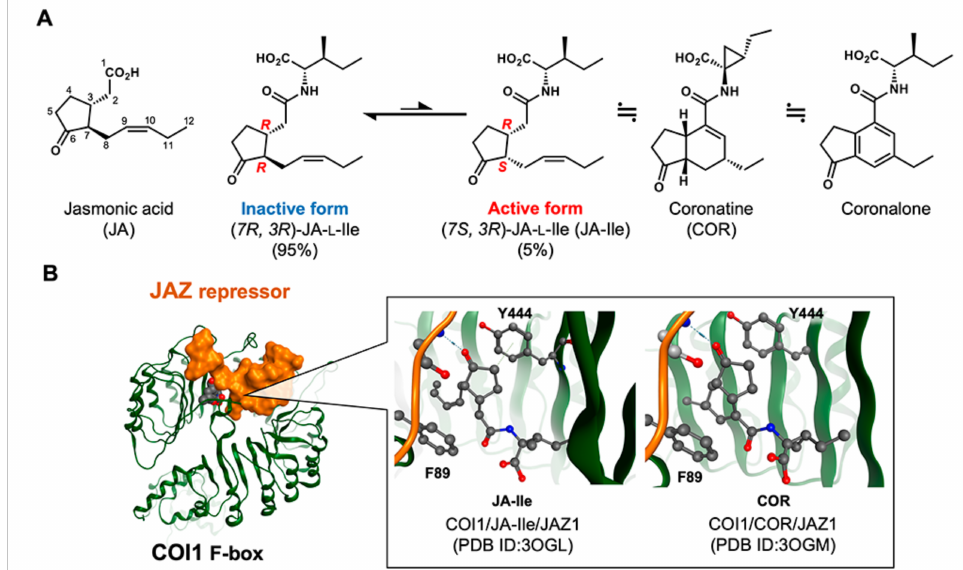
Figure 1. Jasmonic acid (JA) ligands and COI1-JAZ coreceptor. ( A ) Structures of JA, active / inactive form of 7- iso -jasmonoyl- l -isoleucine (JA-Ile), coronatine (COR), and coronalone and ( B ) comparison of the COI1 (green) / JA-Ile / JAZ1 (orange) complex ( left , PDB:3OGL) and the COI1 / COR / JAZ1 complex ( right , PDB:3OGM) at the ligand binding pocket. 89 Phe and 444 Tyr sidechains of COI1 are highlighted in